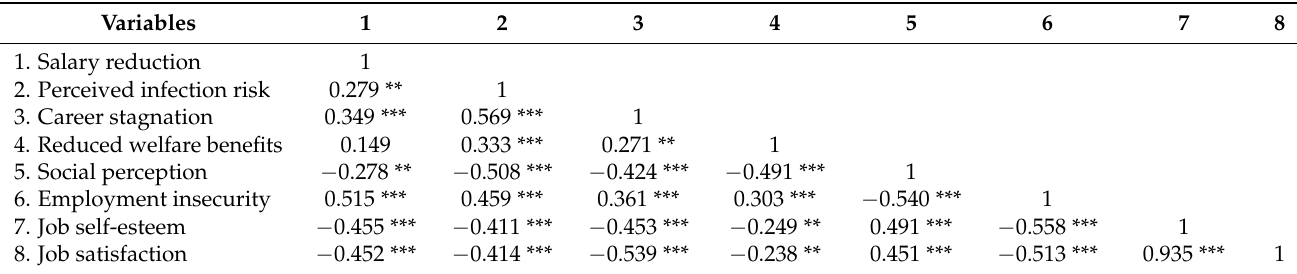
Table 4. Correlation analysis result.